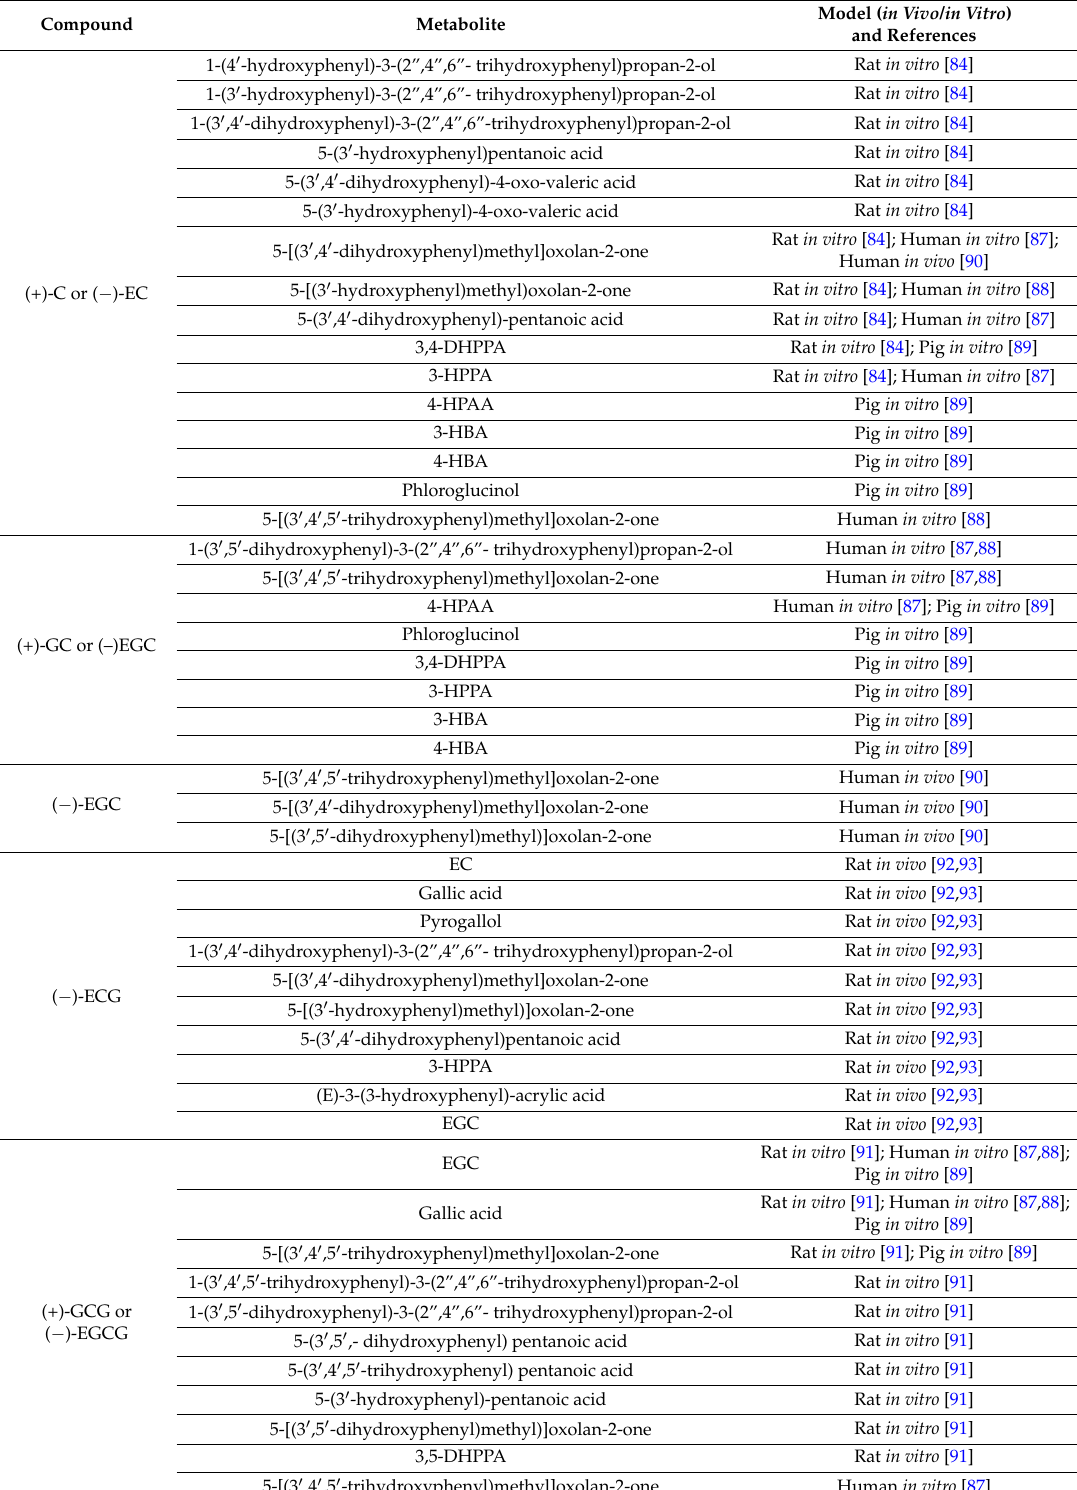
Table 1. In vitro and in vivo biotransformation of flavan-3-ols by gut microbiota. Compound Metabolite